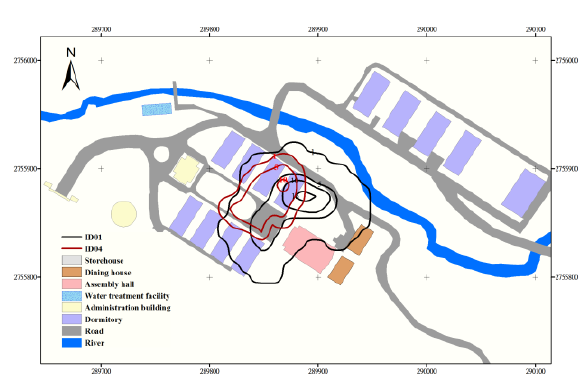
Figure 2. The temporal location map of Subjects’ daily movements. The contour value represents the percentage of staying time in a day for one